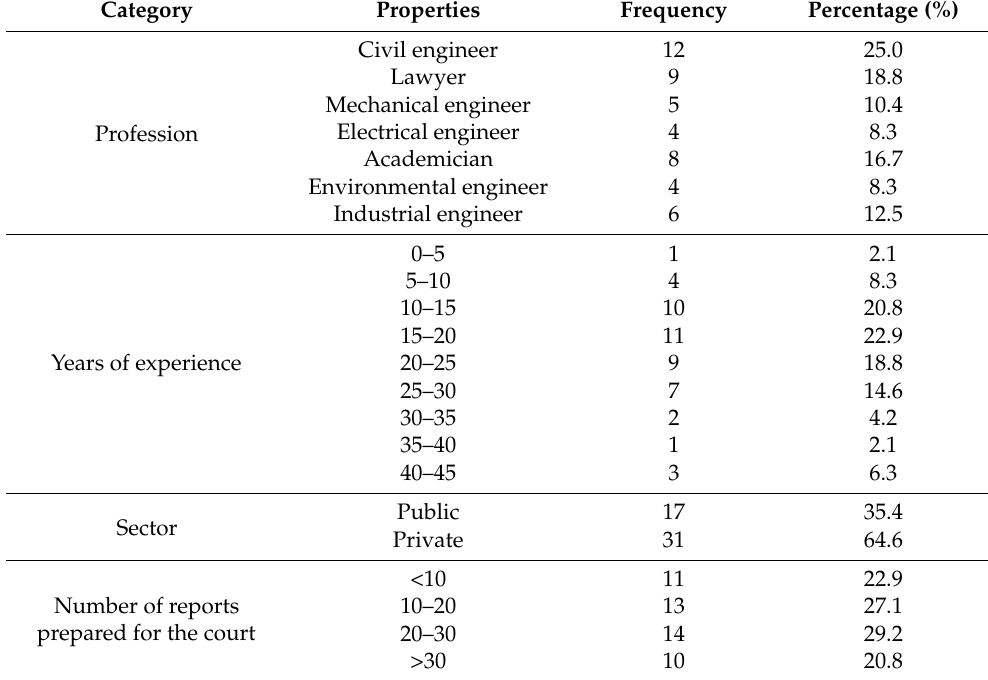
Table 5. Profile of the 48 Experts who responded to the